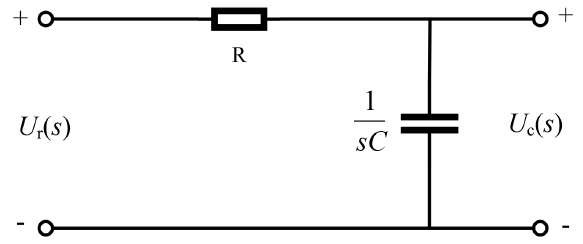
Figure 12. Schematic of RC low-pass filter.